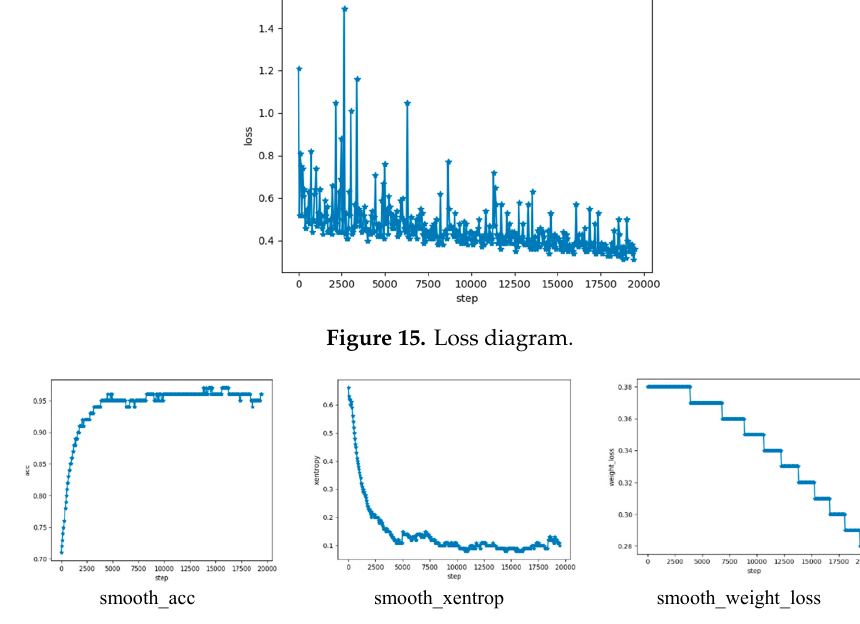
Figure 16. Accuracy, cross-entropy, and loss diagram.